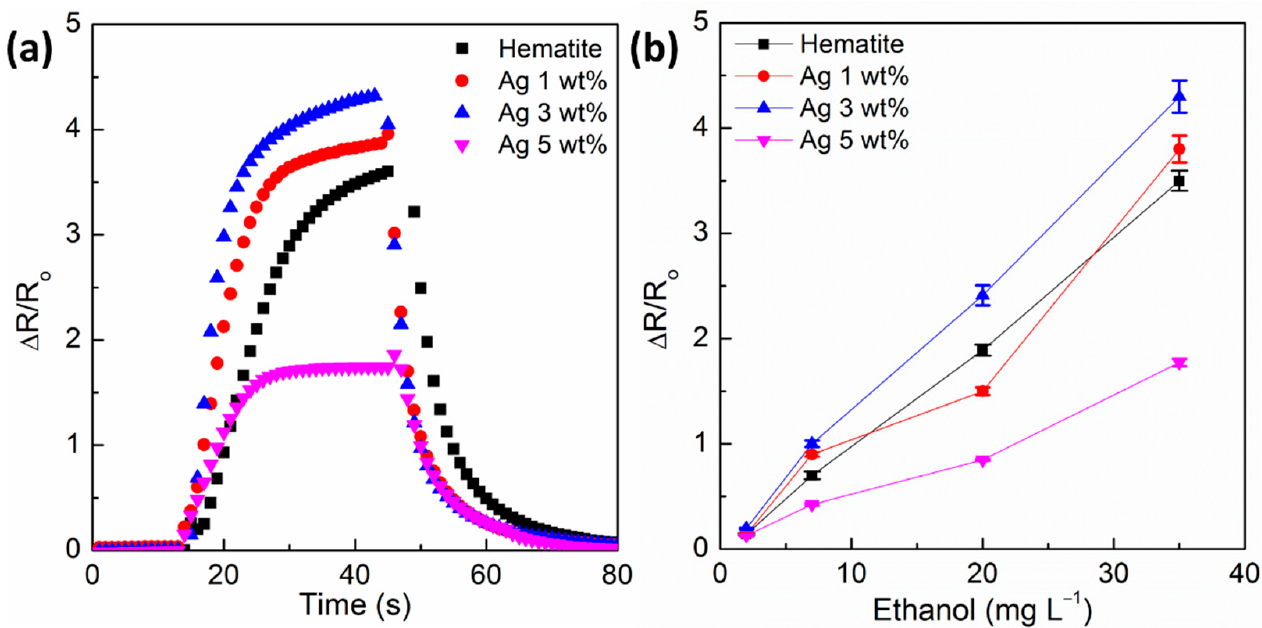
Figure 5. Effect of Ag loading on the sensor sensitivity to ethanol: ( a ) Comparison of the sensors signal when exposed to 35 mg L − 1 of ethanol vapor at 25 °C, ( b ) signal response as a function of ethanol vapor concentration. Composite nanosensors: ( ) Pristine hematite, ( ) α -Fe 2 O 3 /Ag 1.0 wt%, ( ) α -Fe 2 O 3 /Ag 3.0 wt%, and ( ) α -Fe 2 O 3 /Ag 5.0 wt%.